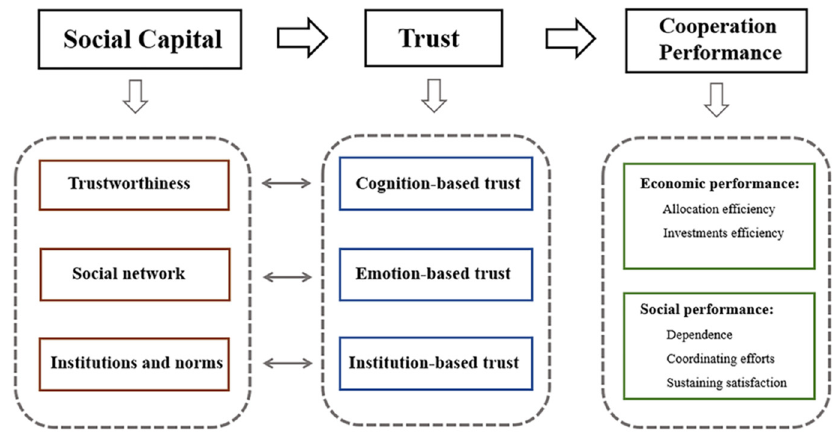
Figure 5. The overall conceptual or theoretical framework for the joint analysis of social capital, trust and cooperation